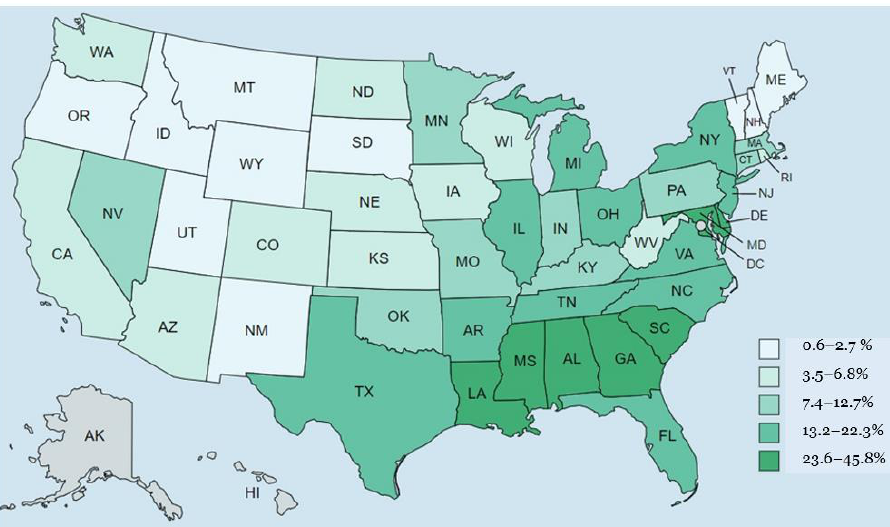
Figure 3. The figure shows the population distribution of African Americans in different states of the US. The population data are obtained from US Census